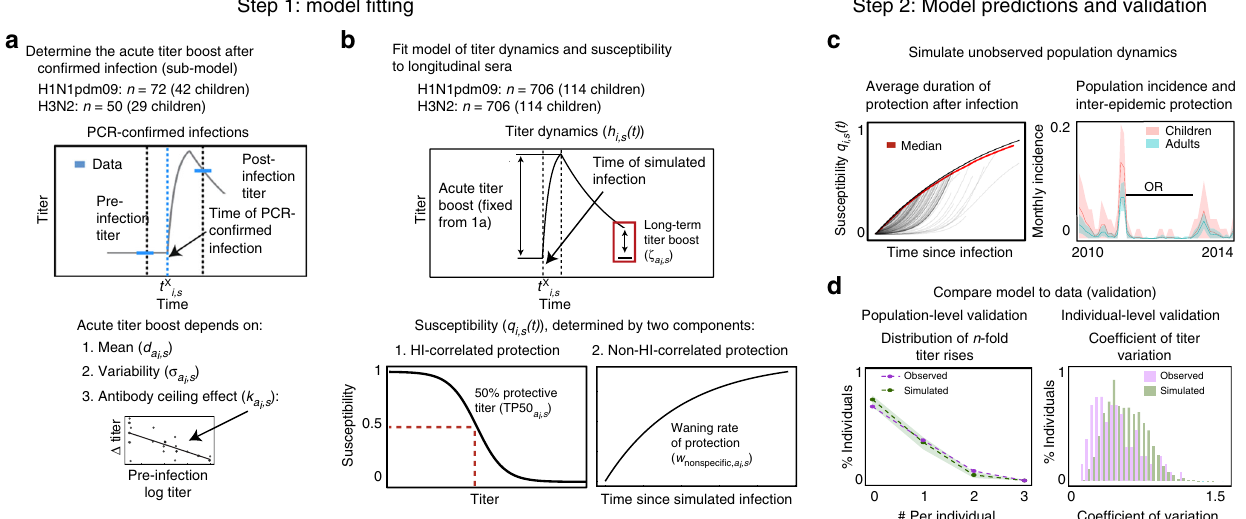
Fig. 1 Schematic of modeling approach. Steps 1 and 2 are performed for each subtype. Step 1: Model fi tting. a First, the sub-model of short-term post- infection titer dynamics is fi tted to a subset of the data. This subset includes the time of PCR-con fi rmed infection and the immediate pre- and post-infection titers. The mean and standard deviation of the acute titer boost and the mean ’ s dependence on pre-infection titer (the antibody ceiling effect) are fi tted. b Next, fi xing the parameters associated with short-term titer dynamics ( a ), the full model is fi tted to titers from the entire cohort. The contribution of HI- correlated and non-HI-correlated protection, the titer waning rate, the 50% protective titer, and the long-term boost after infection are estimated. Step 2: Model predictions and validation. c The duration of protection and inter-epidemic protection are estimated from simulating population-level dynamics from the best- fi t model in b . From the latent infections and susceptibility for each individual, we track the loss of protection after infection. We also estimate the cumulative epidemic incidence and the odds ratios (OR) of protection between epidemics. d Simulation enables additional checks of the model. We compare the simulated and observed distributions of n -fold titer rises and coef fi cients of titer variation among